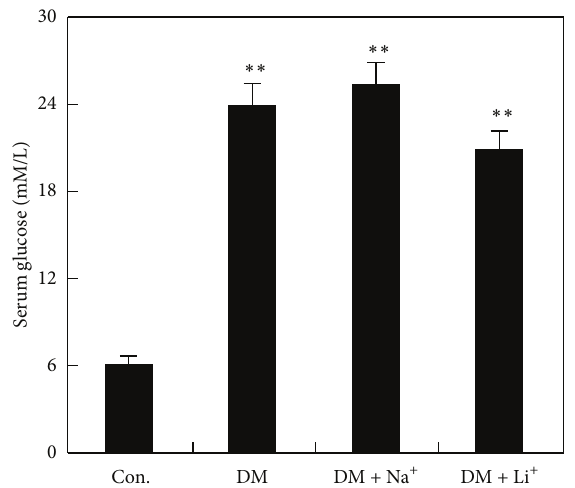
Figure 2: The activity of GSK-3. The activities of GSK-3 in hippo- campal extracts from rats injected with STZ, STZ plus NaCl, or STZ plus LiCl were determined by using specific peptide substrates. ∗∗ 𝑃 < 0.01 versus control group, ## 𝑃 < 0.01 versus DM group.